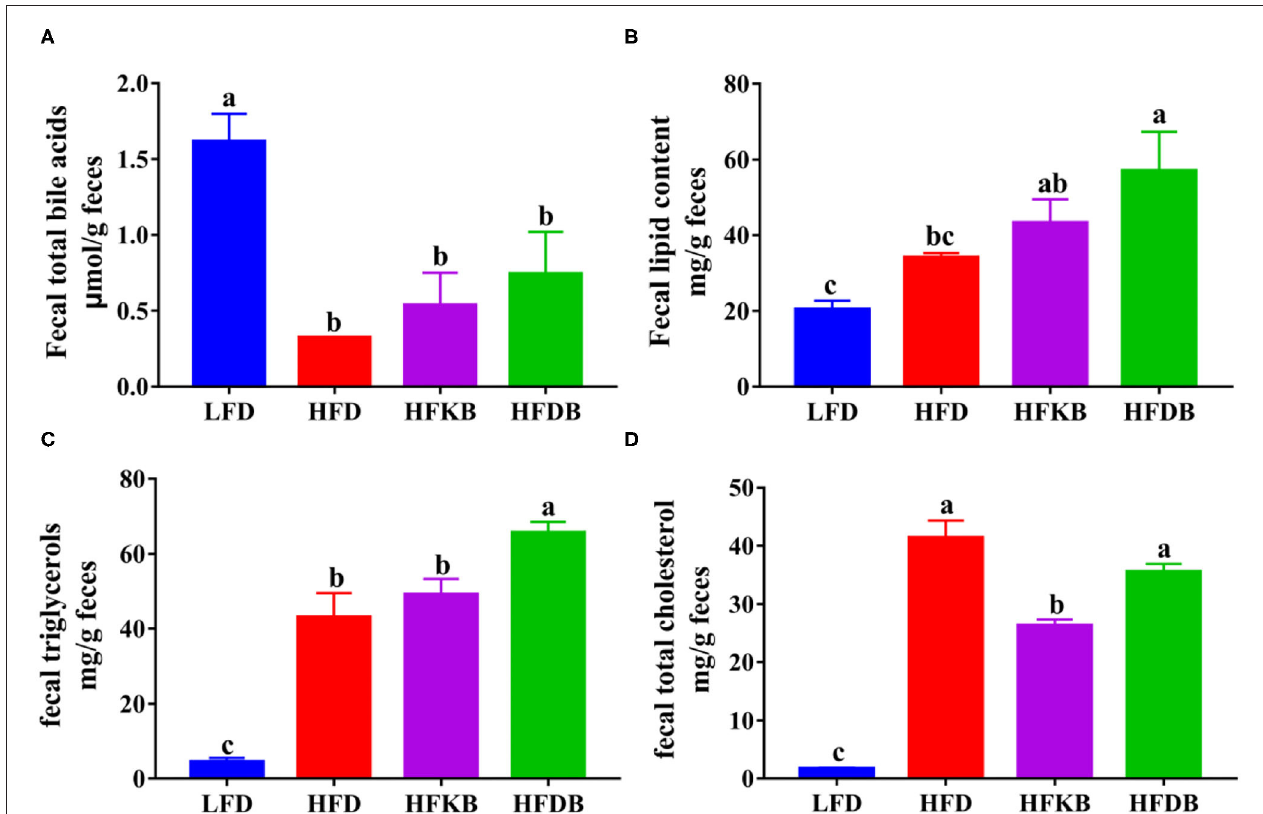
FIGURE 3 | Effects of black tea on fecal total bile acids and lipids. (A) fecal total bile acids; (B) fecal total lipids; (C) fecal triglycerides; (D) fecal total cholesterol. Data are presented as mean ± SEM ( n = 12). a,b,c p represents significant differences among groups (ANOVA, p <